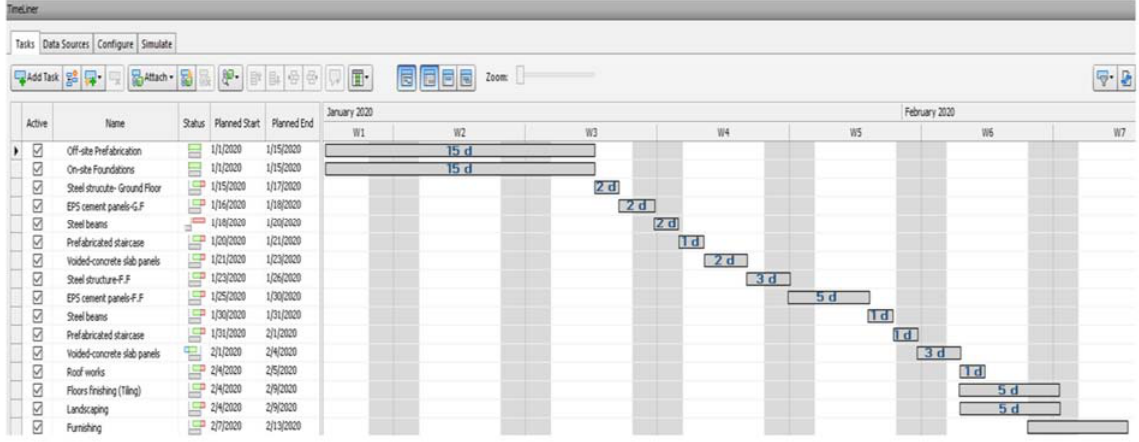
Figure 5. Construction schedule in BIM.